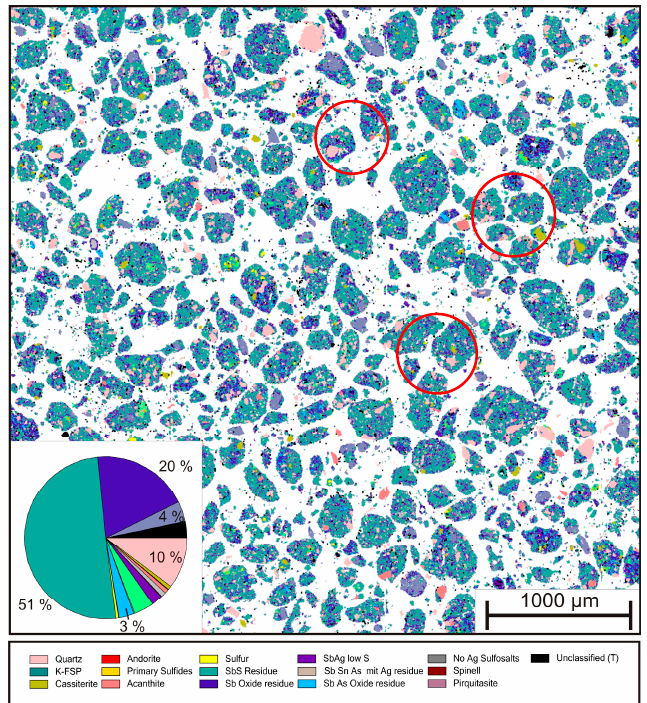
Figure 15. Section overview and modal distribution of leaching residue.